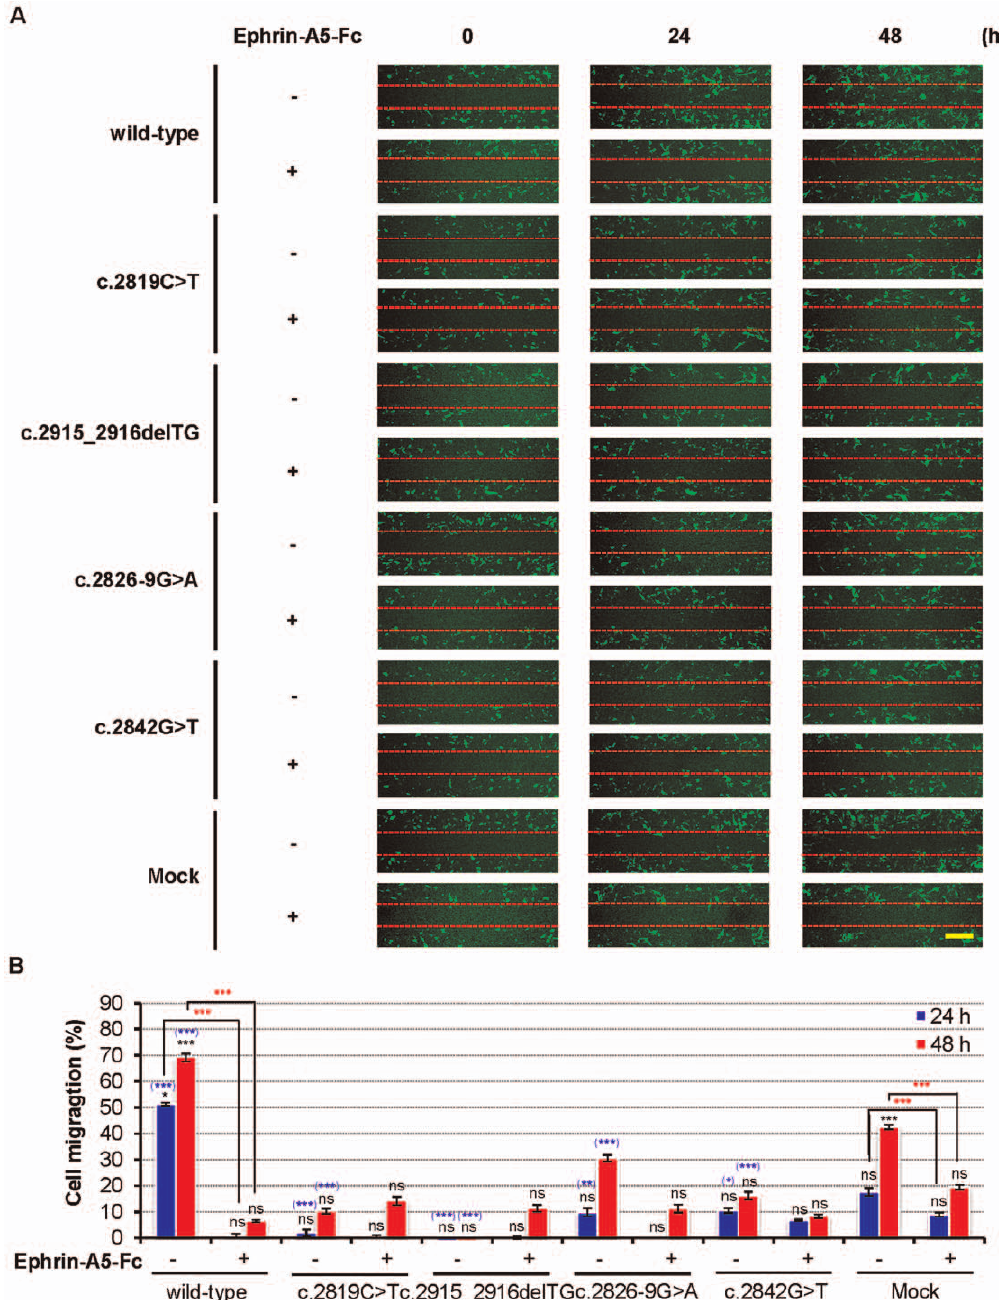
Figure 5. SAM domain of EPHA2 is essential for ligand-independent promotion of cell migration. ( A ) Mutant EPHA2 genes fail to promote a TN4-1 cell migration. a TN4-1 cells were grown to confluency and serum-starved for 24 hours. A scratch wound was made with a micropipette tip and the edge of cells was marked. 2 m g/mL cross-linked ephrin-A5-Fc was then added to the starvation media, and cells were allowed to migrate toward the center of the wound and photographed at the indicated times (representative figure of three independent experiments). The position of the initial scratch is indicated by dotted lines. Scale bar, 500 m m. ( B ) Quantification of the effects of EPHA2 genes on a TN4-1 cell migration. The graphs represent the measurement of migration distance from three independent experiments. Mean values are presented with + S.D as indicated. Statistical differences were analyzed using one-way analysis of variance (ANOVA) or calculated by a two-tailed student t-test. Blackasterisks , comparison between time 0 and 24 hours and time 0 and 48 hours; Blueasterisks , comparison between the mock groups and the listed wild-type or mutant EPHA2 genes at 24 or 48 hours; Redasterisks , comparison between untreated and treated conditions at 24 or 48 hours. ***, P , 0.001; **, P , 0.01; *, P , 0.05; and ns, not significant. Values of P , 0.05 were considered to be statistically significant. doi:10.1371/journal.pone.0036564.g005 contain five a helical domains [25,47]. Our studies suggest that the the specific effects of EPHA2 SAM domain mutations, we SAM domain of the EPHA2 protein modulates ubiquitinylation investigated the stability of the mutant EPHA2 proteins in two and regulates the stability of the receptor. As a first step to examine different cell lines, HEK293T and a TN4-1. Our results show that